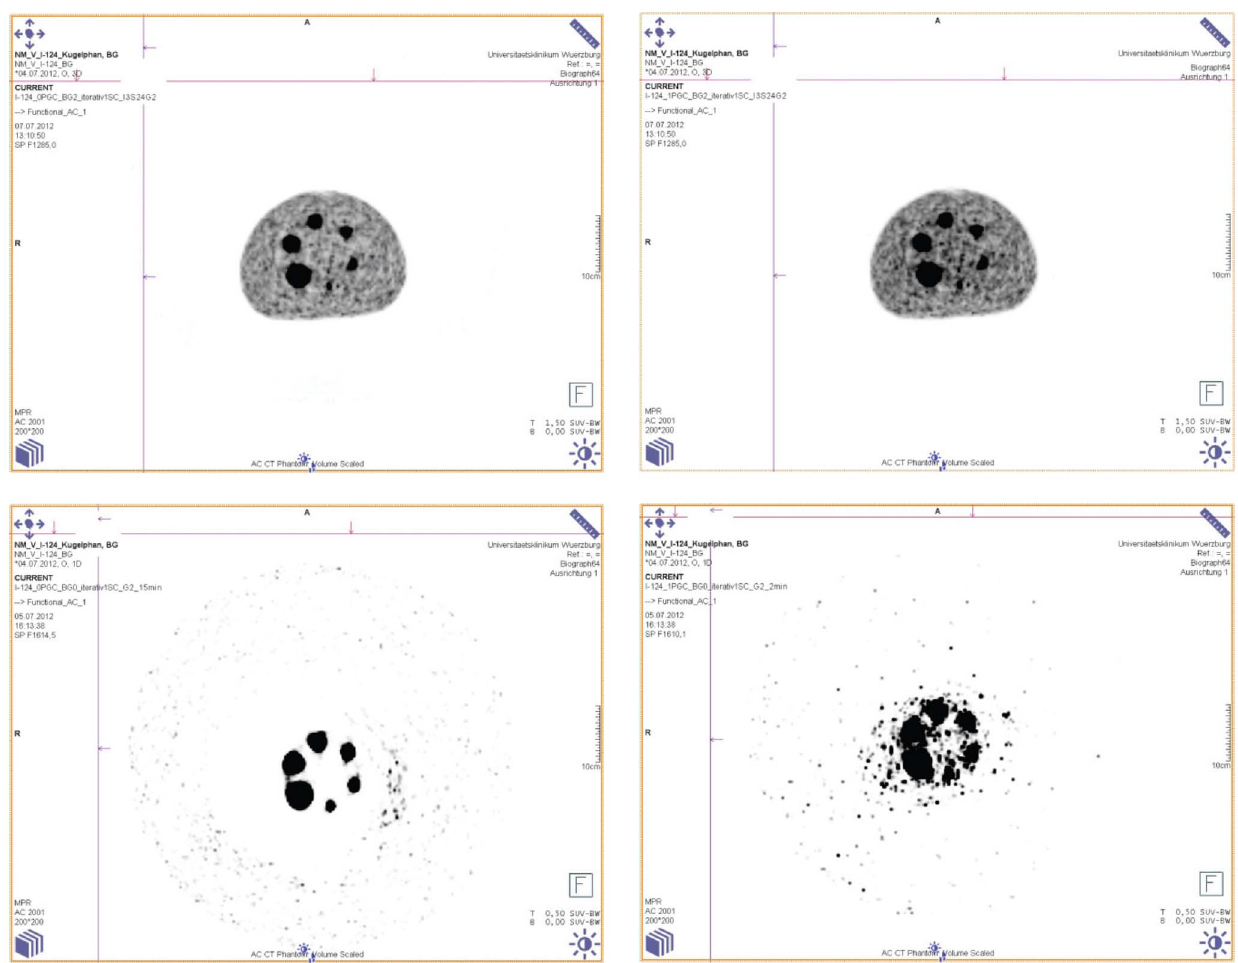
Figure 6. Transaxial views of I-124 phantom images with PGC (right) and without PGC (left), top: with background activity, bottom: without background activity.